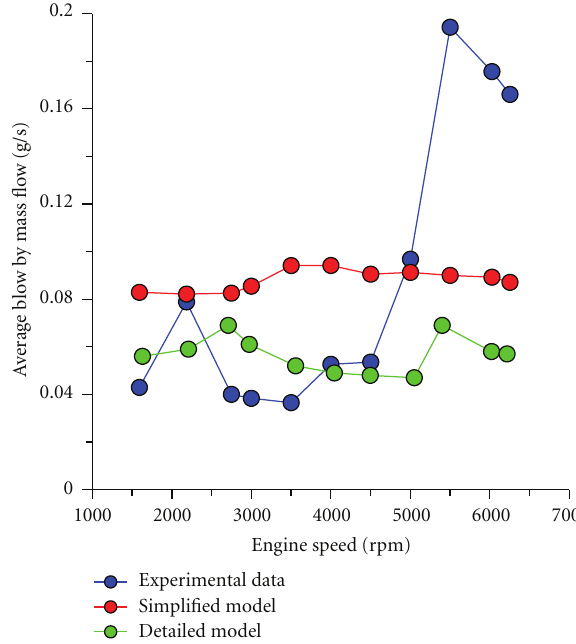
Figure 13: Blow-by models